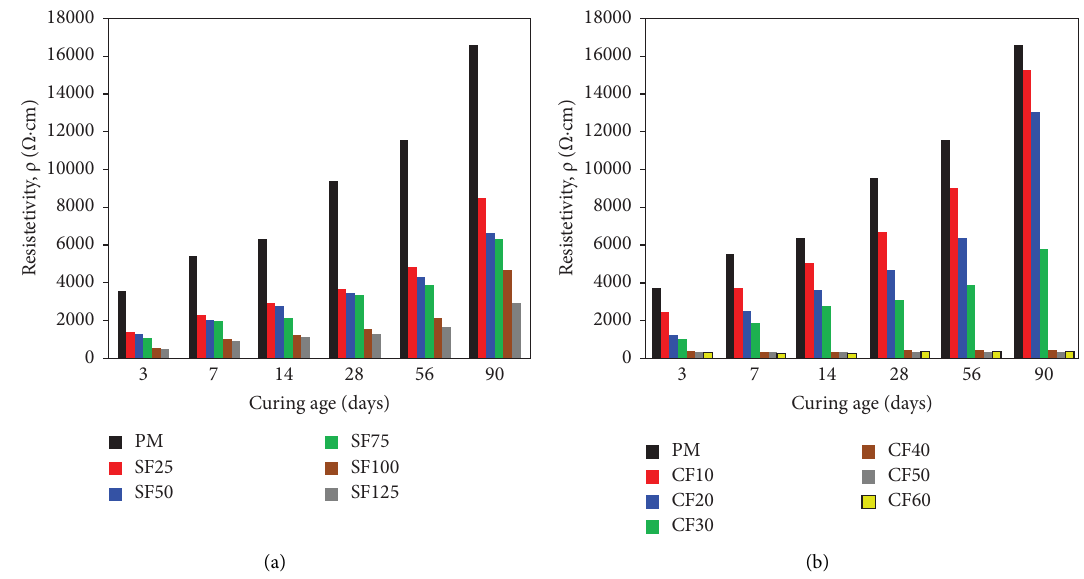
Figure 7: Electrical resistivity of conductive cement composites with diferent curing ages (days). (a) SF specimens and (b) CF specimens.